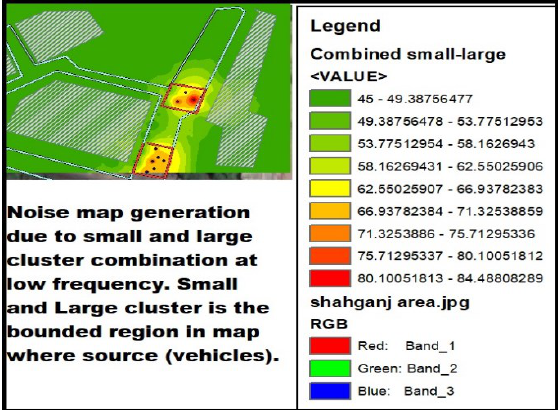
Figure 14. Noise map for the combination of the small and large cluster at low freq. 31.5Hz.